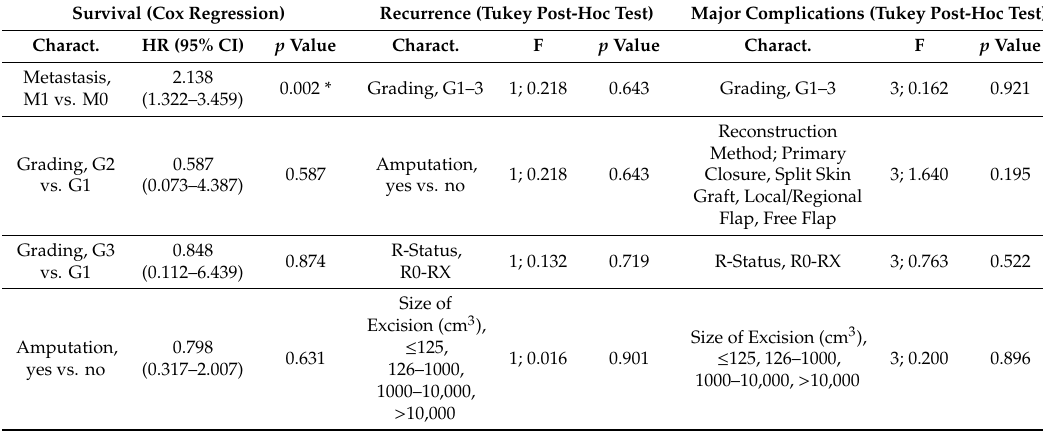
Table 9. Results of multivariate analysis on survival using the Cox regression hazard model on recurrence and surgical complications using a Tukey post-hoc test. * indicates statistical significance ( p ≤